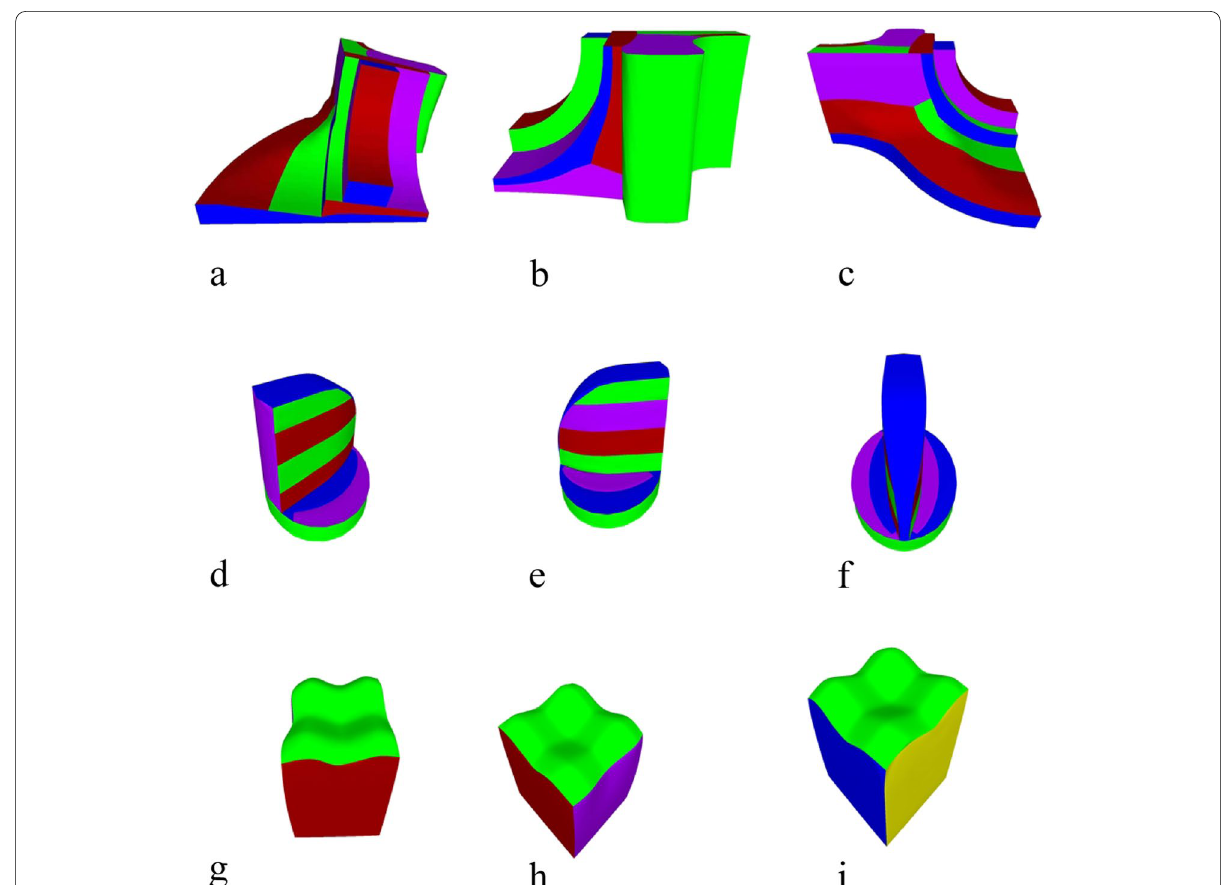
Fig. 18 Mesh segmentation: a ‑ c Fandisk model; d ‑ f Spheredisk model; g ‑ i Surfcube